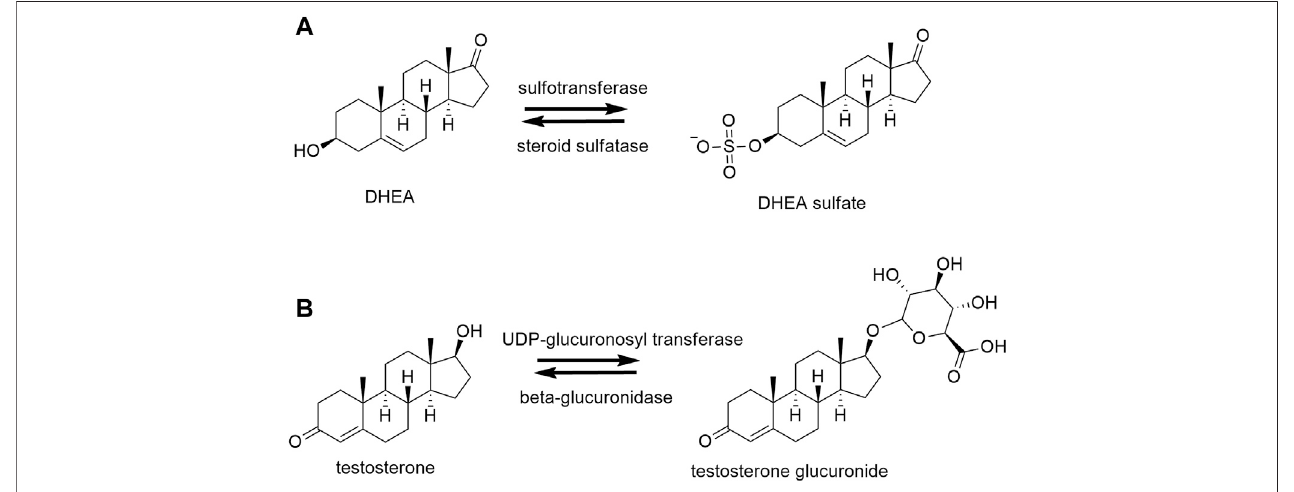
FIGURE 2 | Conjugation and deconjugation reactions. (A) Example of sulfation and desulfation reactions of dehydroepiandrosterone (DHEA) by sulfotransferase and steroid sulfatase, respectively. (B) Example of glucuronidation and deglucuronidation of testosterone by uridine 5 ′ -diphospho (UDP)-glucuronosyltransferase and β -glucuronidase,